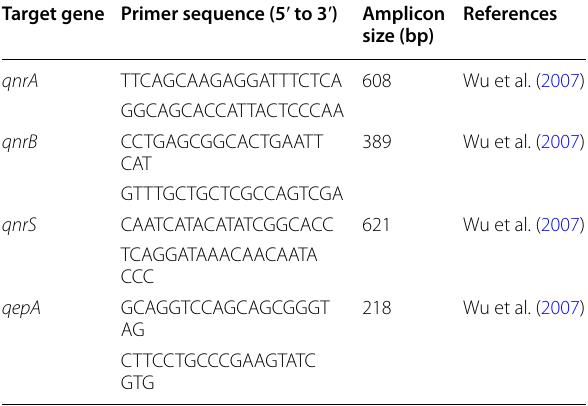
of ciprofloxacin-resistant bacterial